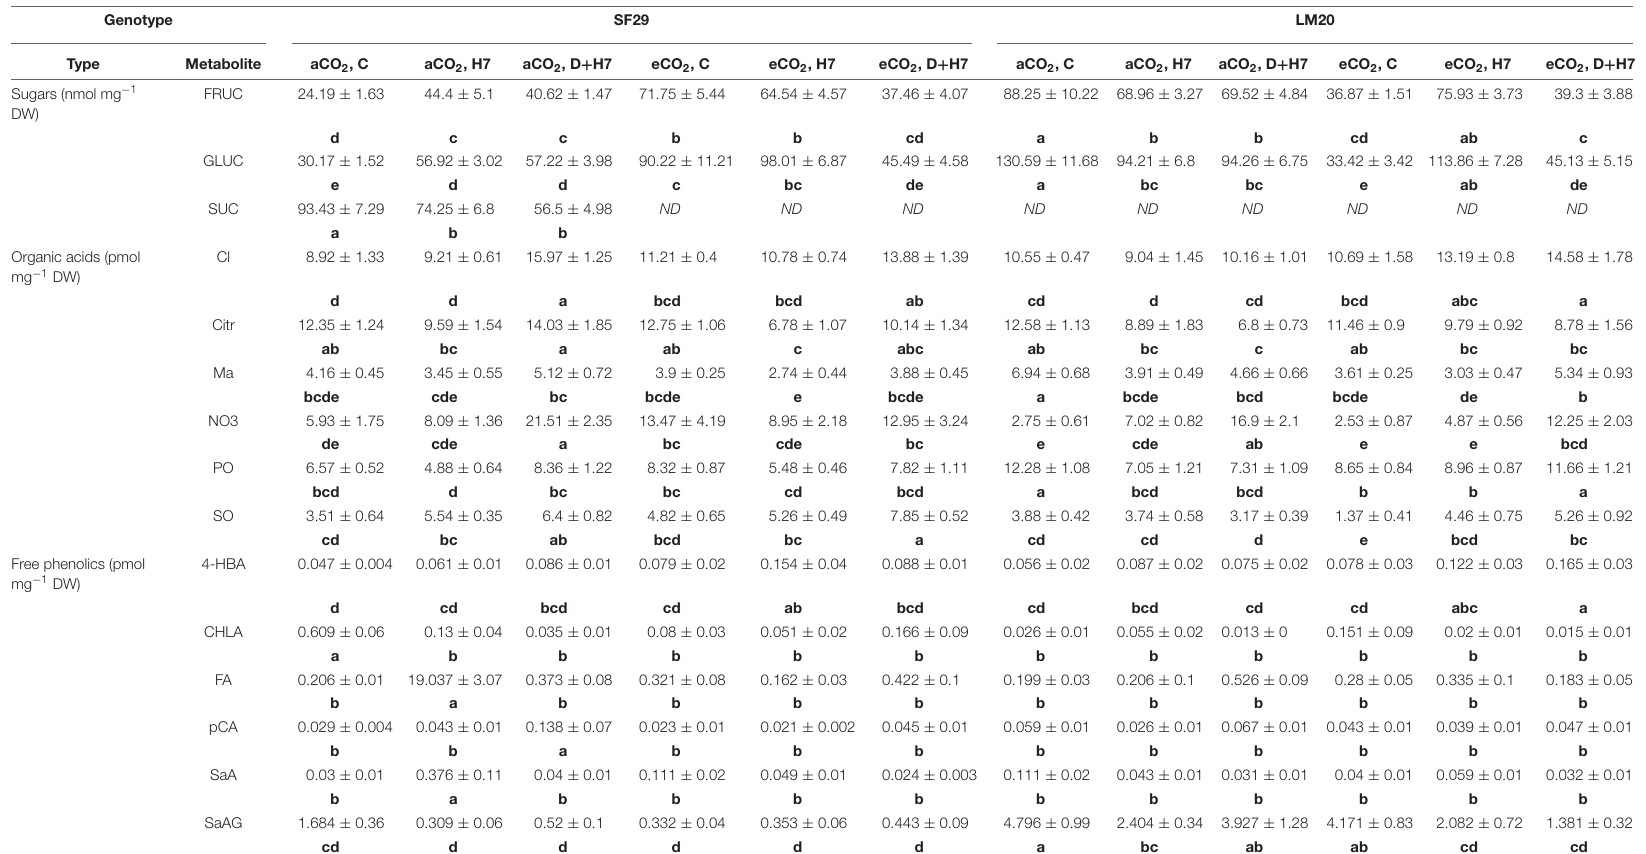
TABLE 1 | Primary and secondary metabolites in a heat-sensitive (SF29) and heat-tolerant (LM20) genotypes grown under control conditions (C), heat stress at day 7 (H7) and combined heat stress and drought at day 7 (D + H7) at ambient CO 2 (aCO 2 ) or elevated CO 2 (eCO 2 ).